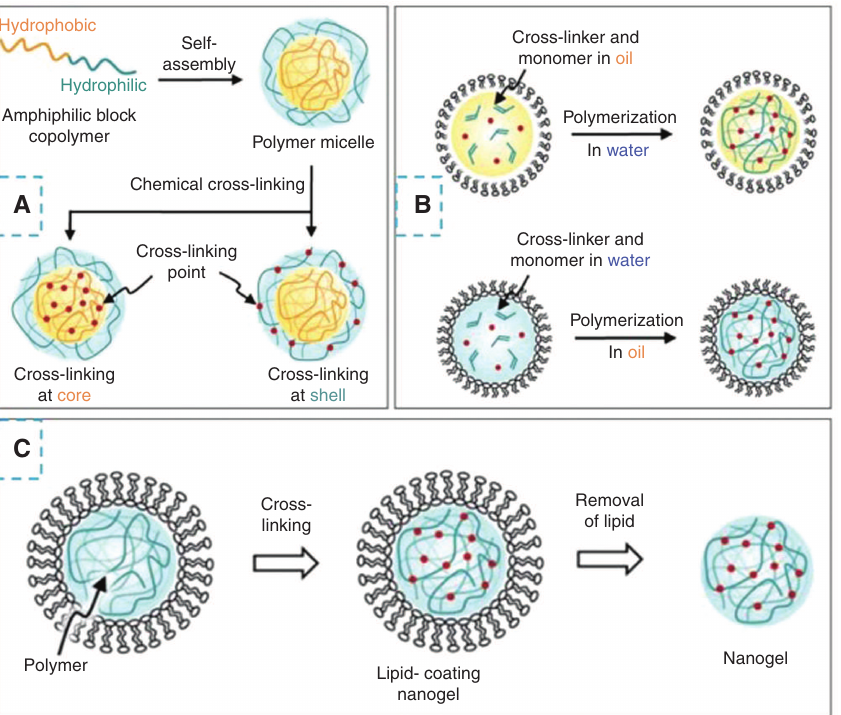
Figure 9: The chemically prepared nanogel by: (A) Crosslinking of amphiphilic block copolymer at core or shell of the polymer micelles in water. (B) Emulsion polymerization with/without emulsion. (C) Using liposome as a template. Adapted from Ref. [5], Copyright (2010) with permission from John Wiley & Sons, Inc.